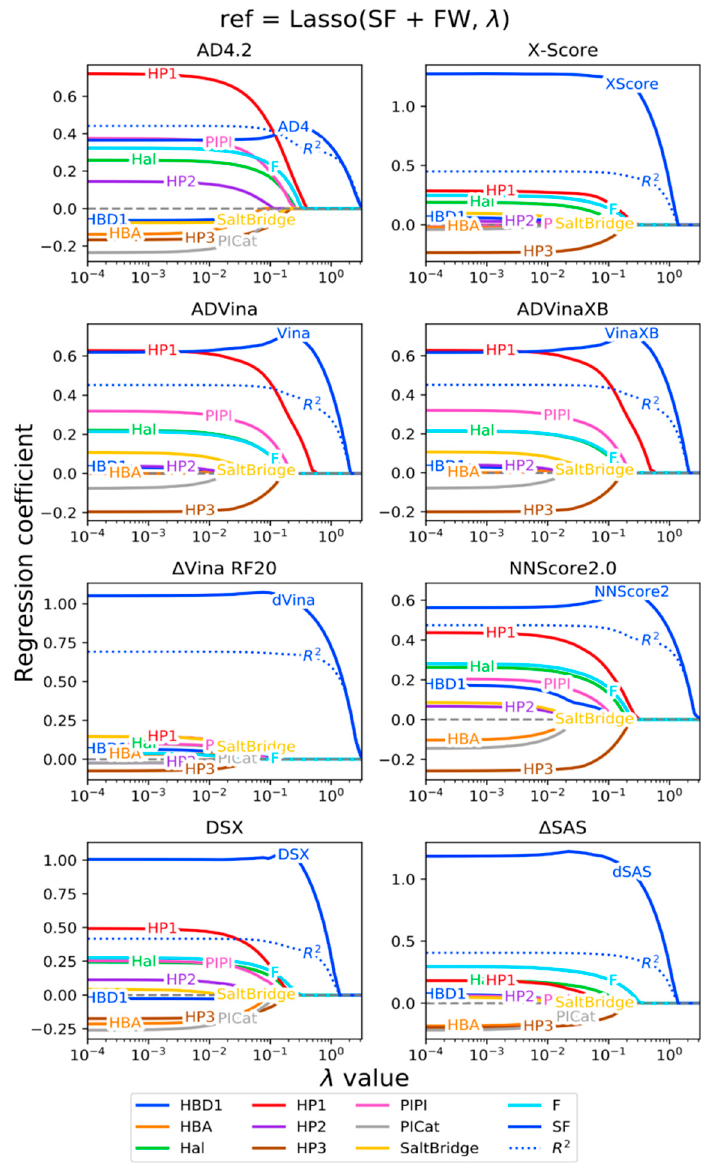
Figure 3. Statistical performance ( R 2 ) and the values of the coefficients of the Lasso model, relating the experimental and the combined model, including score function prediction and a presence of chemical features responsible for basic interactions. Increasing the magnitude of the regularization parameter, λ , results in that the non-zero coefficients remain only for the most statistically significant features .